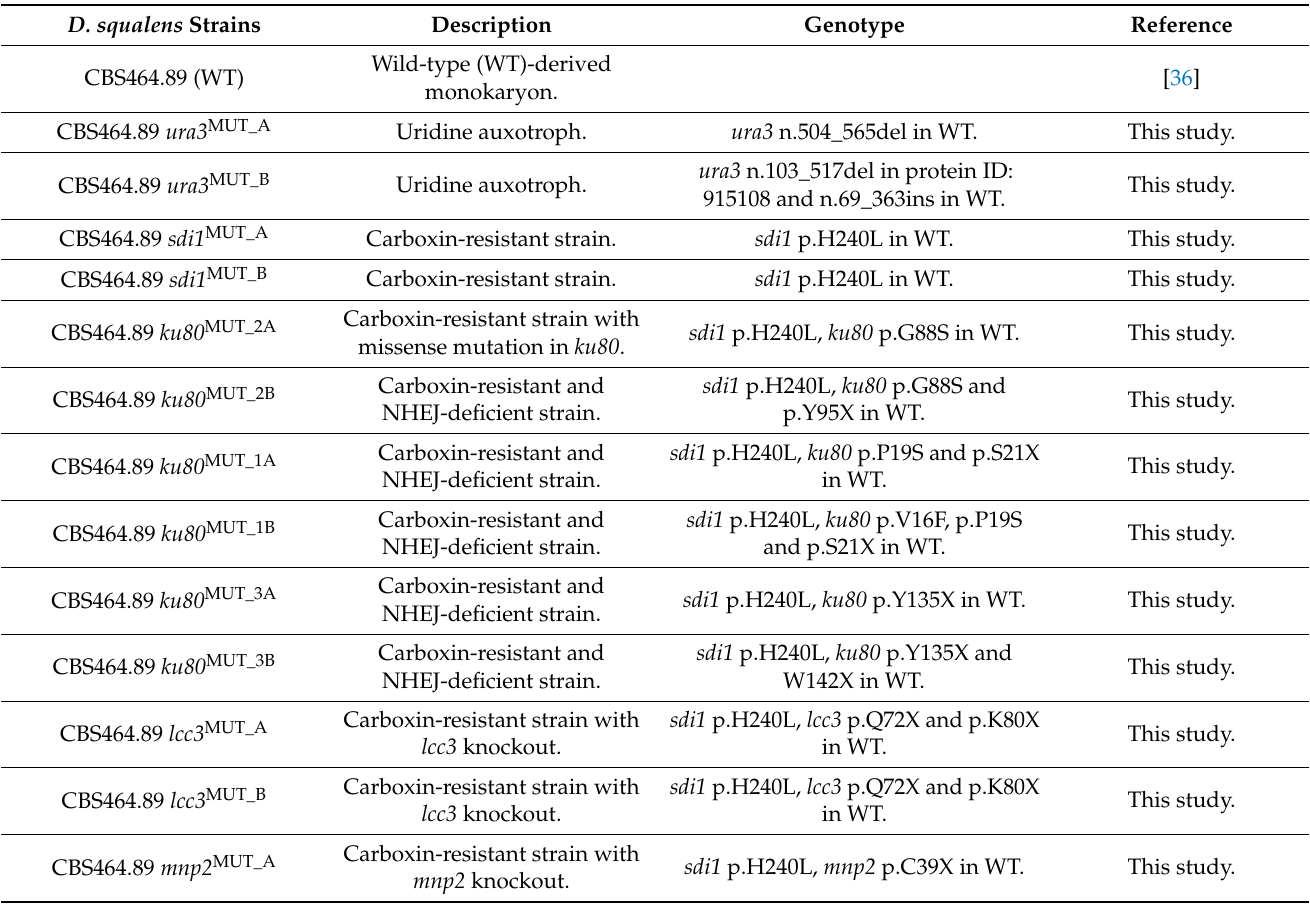
Table 1. Dichomitus squalens strains used in this